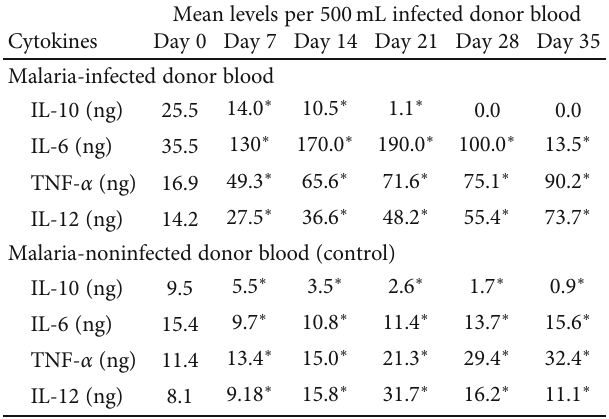
Figure 2: Changes in haematological parameter levels in donor whole blood stored for 35 days: (a) changes in total white blood cell levels, (b) changes in platelet levels, (c) changes in red blood cell levels, and (d) changes in haemoglobin levels. Table 2: Amounts of cytokines released into an average of 500mL of stored whole